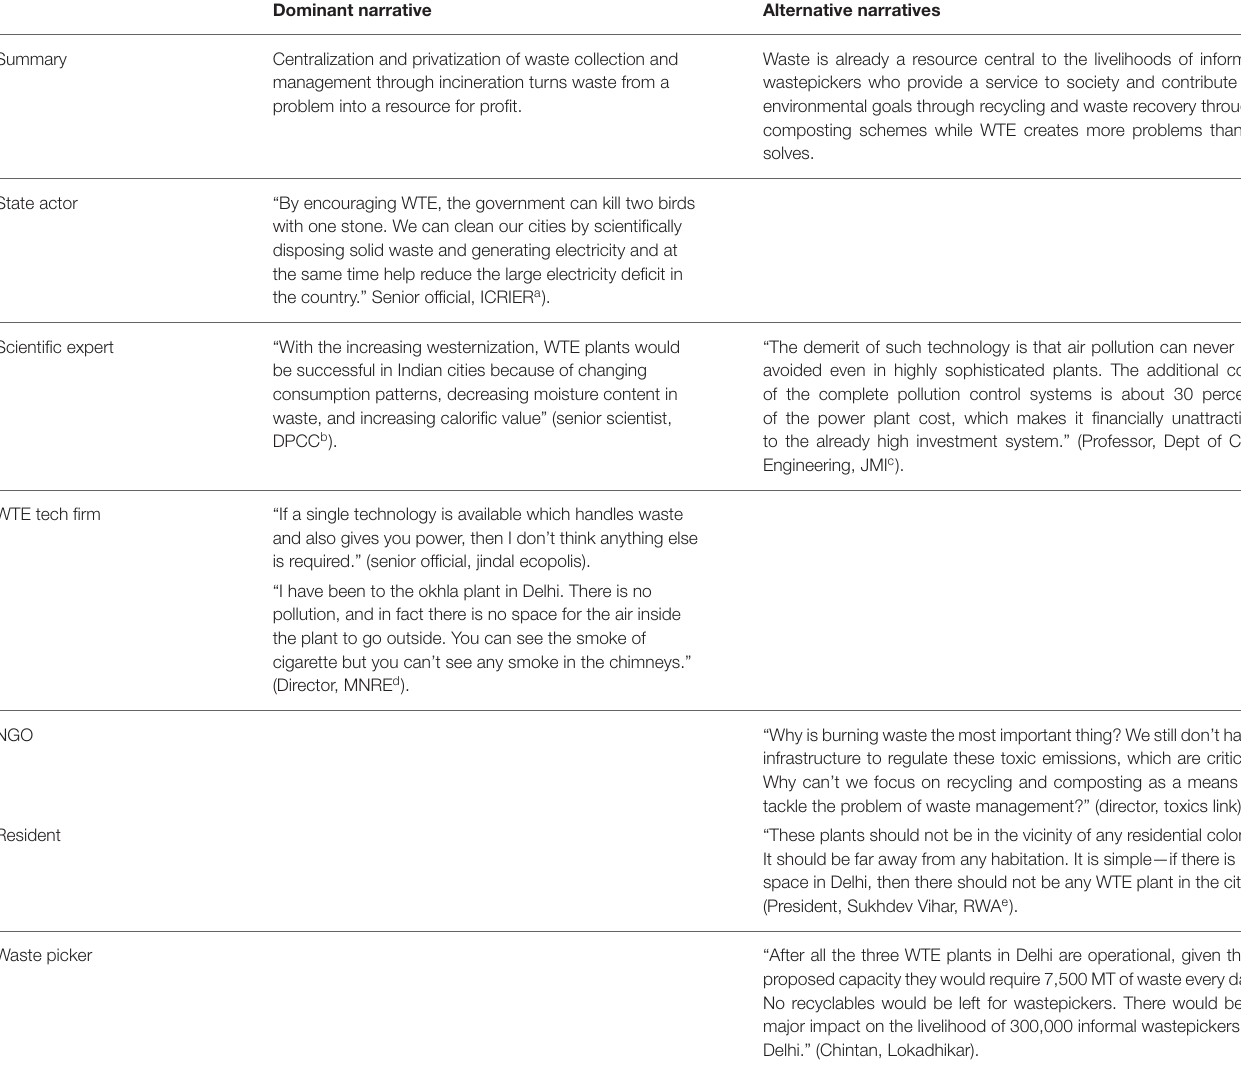
TABLE 2 | Dominant and alternative narratives concerning the problem of solid waste management in Delhi and its proposed